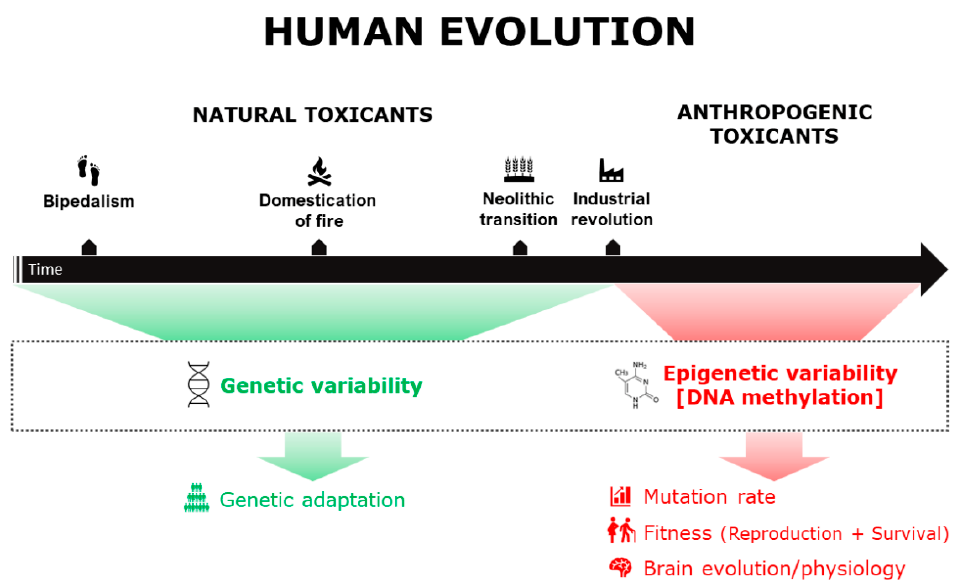
Figure 1. Illustrative timeline of the different events that exposed humans to different toxic sub- stances during human evolution. Natural and anthropogenic toxicants, which in turn led to genetic adaptations and epigenetic variability, are reported in green and red, respectively. The effects of modern toxicants on DNA methylation played a key role in shaping the mutation rate, biological fitness (in terms of reproduction and survival), and evolution of the human brain.